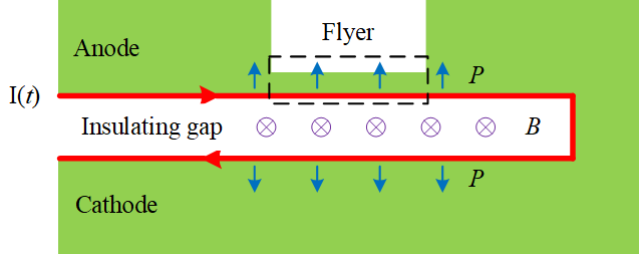
Figure 5. Schematic diagram of magnetically driven flyer.